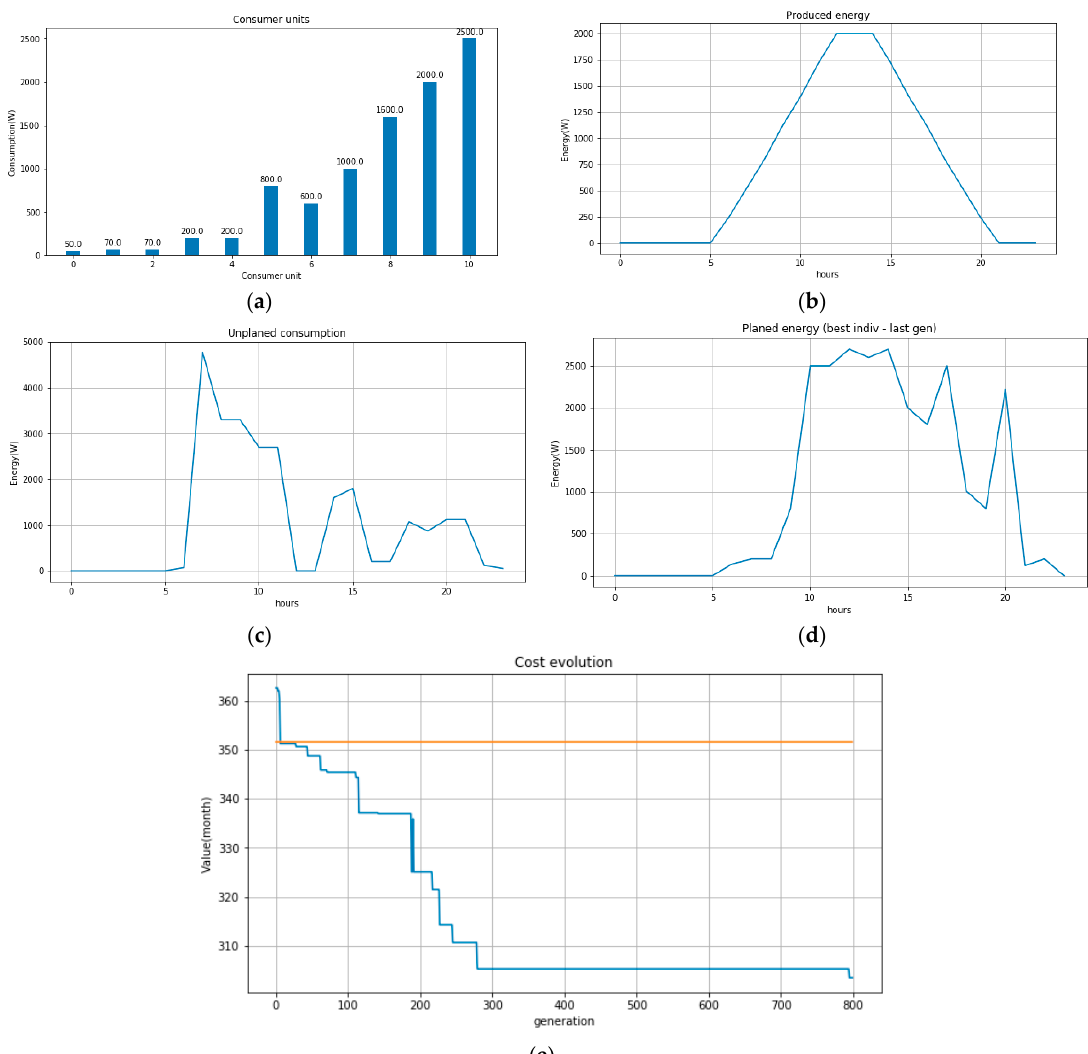
Figure 11. Results for the domestic consumer case study presented in this section. ( a ) Consumer Units; ( b ) Produced Energy; ( c ) Unplaned Consumption; ( d ) Planed Energy; ( e ) Cost